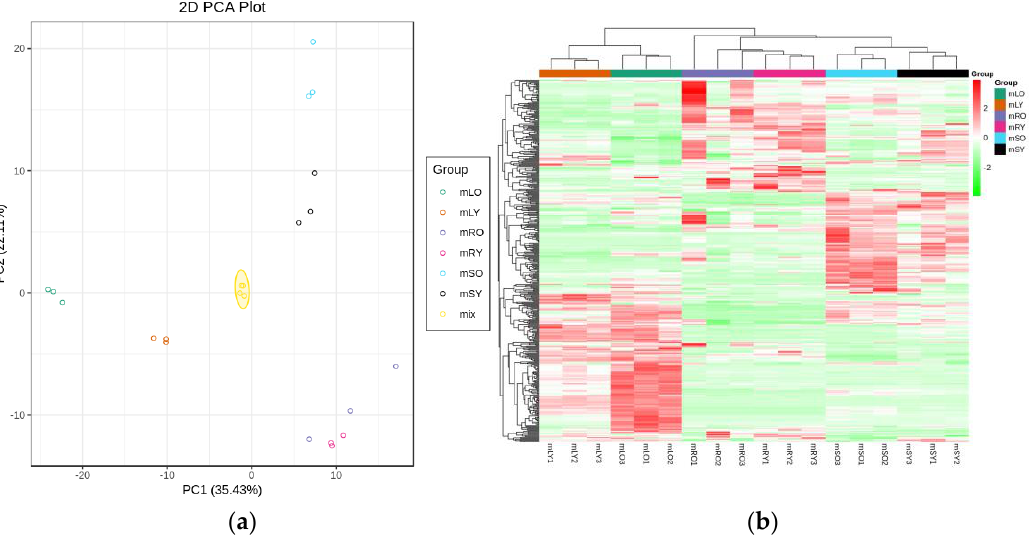
Figure 8. Analysis of A. ilicifolius metabolome samples. ( a ) Principal component analysis (PCA) of the young and mature root, stem, and leaf samples. The ordinate represents the clustering of samples, and the abscissa represents the clustering of metabolites. ( b ) The overall clustering map of samples is based on metabolite profiles. The horizontal coordinate indicates the sample name (hierarchical clustering result), and the vertical coordinate indicates all metabolites (hierarchical clustering result). mRY, mSY, and mLY represent young roots, young stems, and young leaves, respectively, and mOR, mOS, and mOL represent mature roots, mature stems, and mature leaves, respectively.